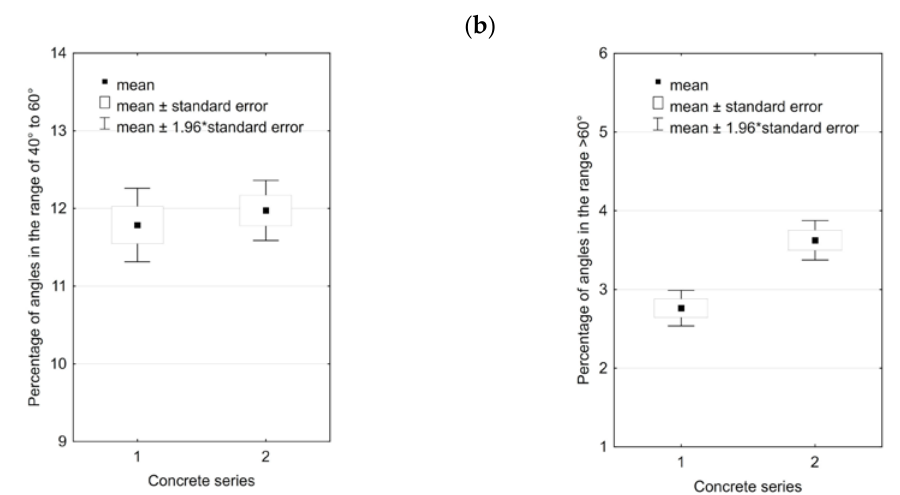
Figure 11. Graphic interpretation of the test for the equality of angles γ i occurrence mean frequency for specimen series 1 and 2 in the range of: ( a ) 40 ◦ to 60 ◦ , ( b ) over 60 ◦ .